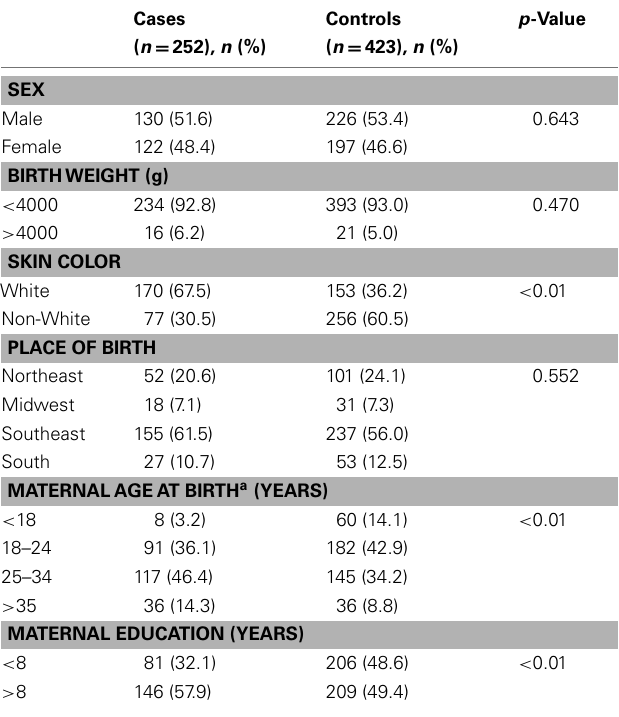
Table 1 | Distribution of selected maternal and child socio-demographic variables, leukemia cases, and controls,